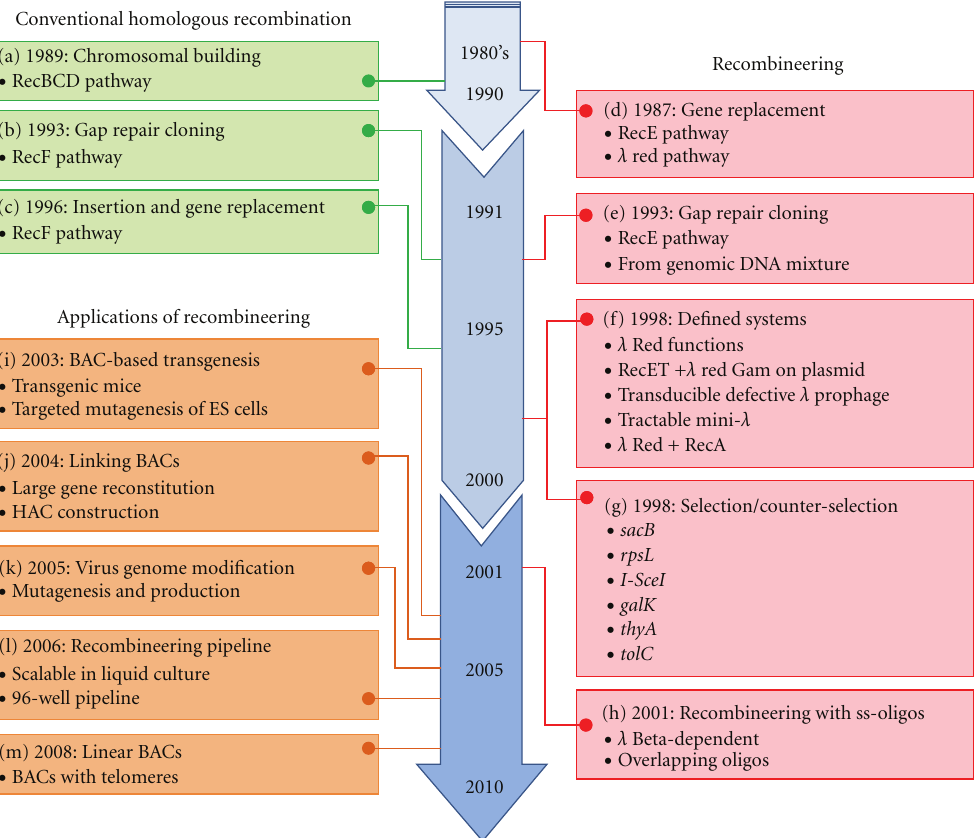
Figure 2: Evolution of recombineering as a major modification strategy for BACs. The evolution of homologous recombination over time since the 1980s is depicted in green (conventional homologous recombination) and red boxes (recombineering), respectively, while major applications of recombineering are depicted in orange boxes. Conventional homologous recombination was the main approach for BAC modifications between 1980s and early 1990s ((a)–(c)), alongside early recombineering techniques mediated by E. coli strains carrying activated λ or Rac recombination functions ((d)-(e)). Following the establishment of defined recombineering systems in late 1990’s (f), recombineering emerged as the favourable method over conventional homologous recombination, and technologies for recombineering rapidly expanded in the next few years ((g)-(h)). Recombineering has, thereafter, been adopted for use in a wide range of biological applications ((i)–(m)). See text for